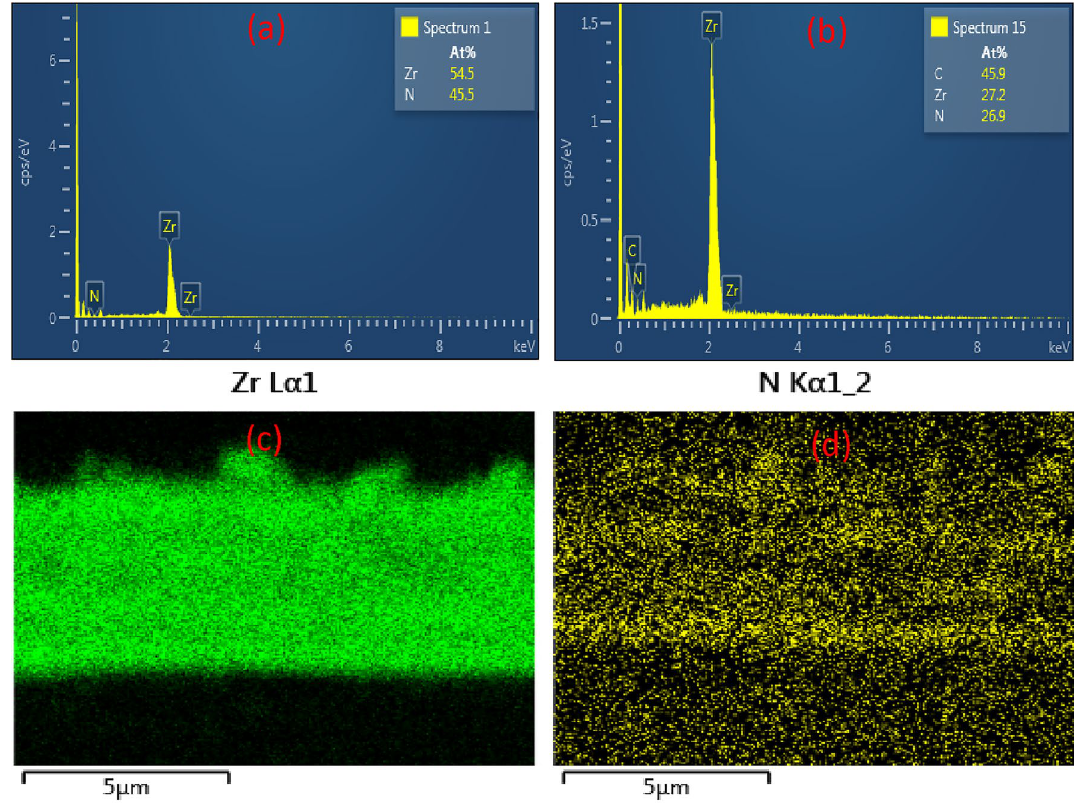
Figure 8. EDS spectra of (a) PN8 & (b) PN12 and X-ray maps of (c) Zr and (d) N for